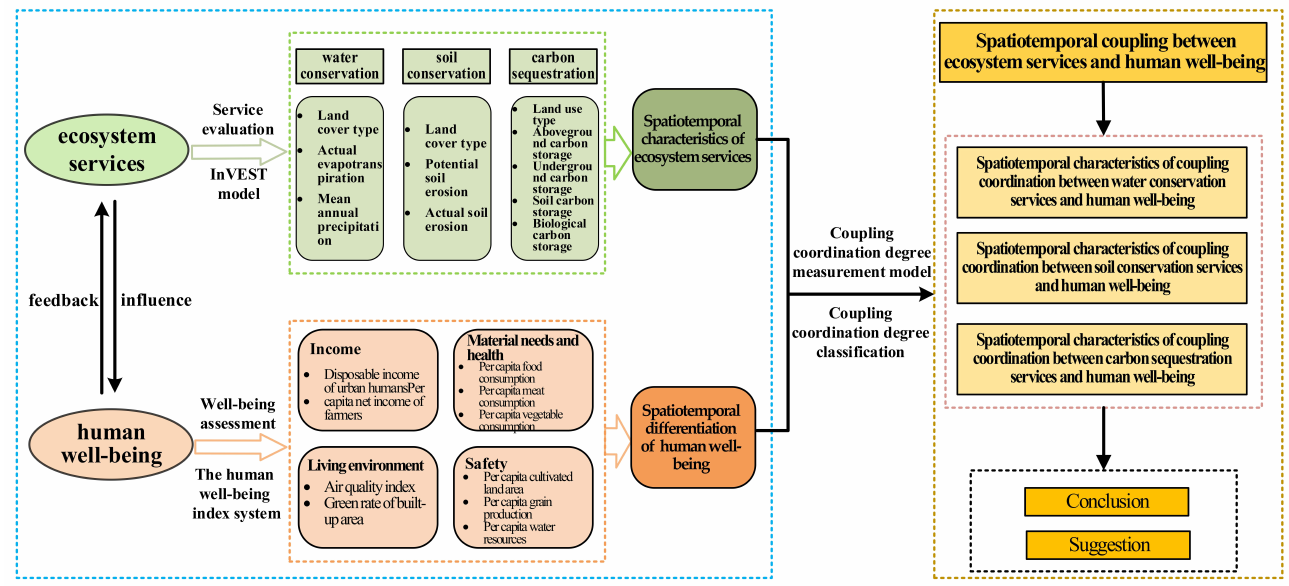
Figure 1. Research